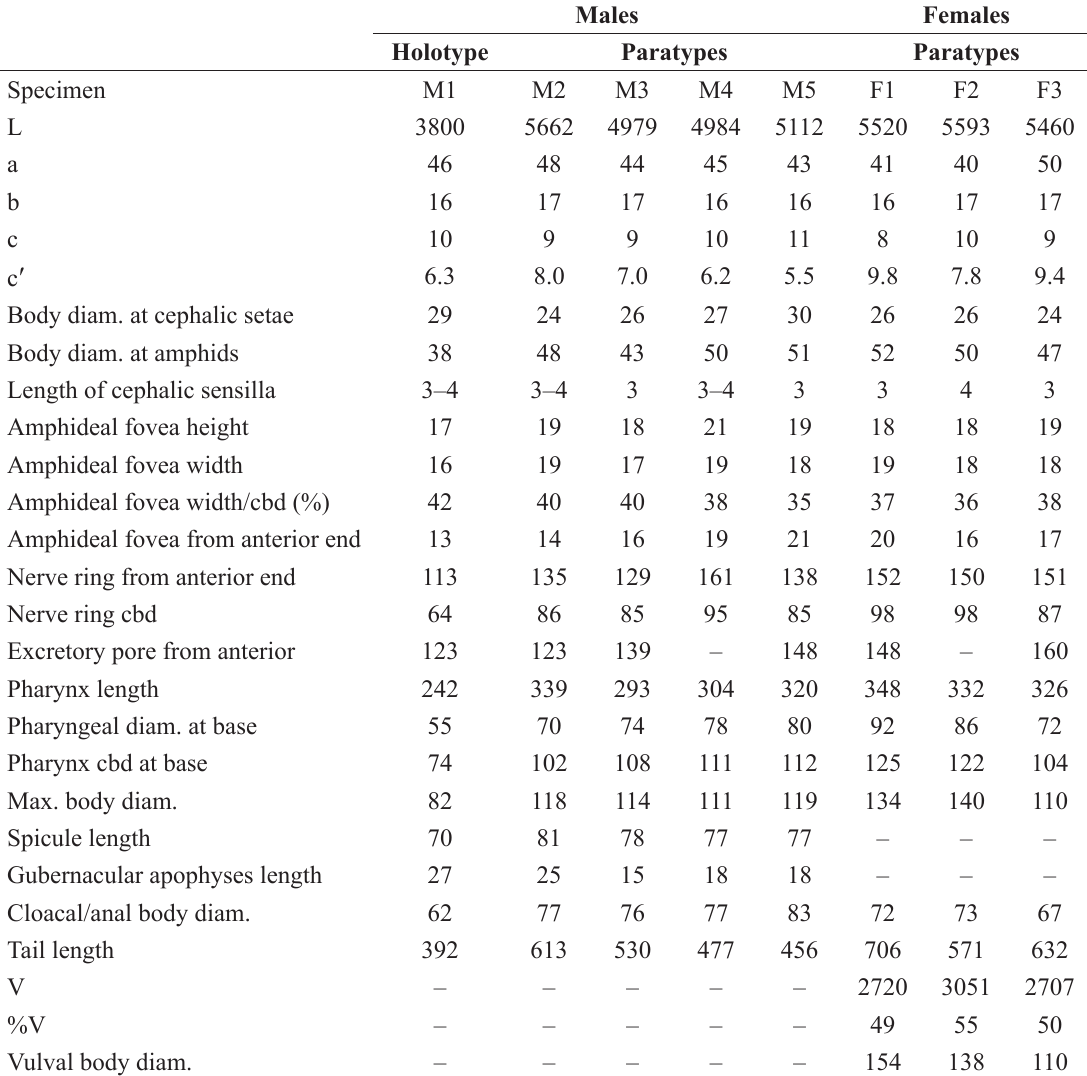
Table 3. Morphometrics (µm) of Linhomoeus pycnocricus sp. nov. Abbreviations: a = body length/ maximum body diameter; b = body length/pharynx length; c = body length/tail length; cʹ = tail length/ anal or cloacal body diameter; cbd = corresponding body diameter; L = total body length; V = vulva distance from anterior end of body; %V = V/total body length ×